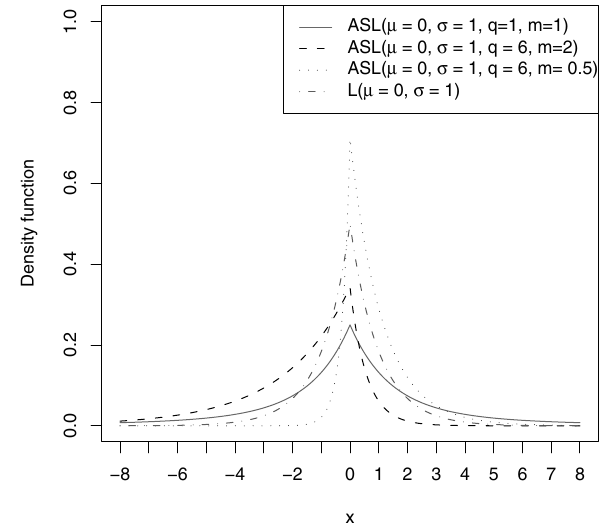
Figure 3 – Asymmetric slash Laplace densities along with Laplace